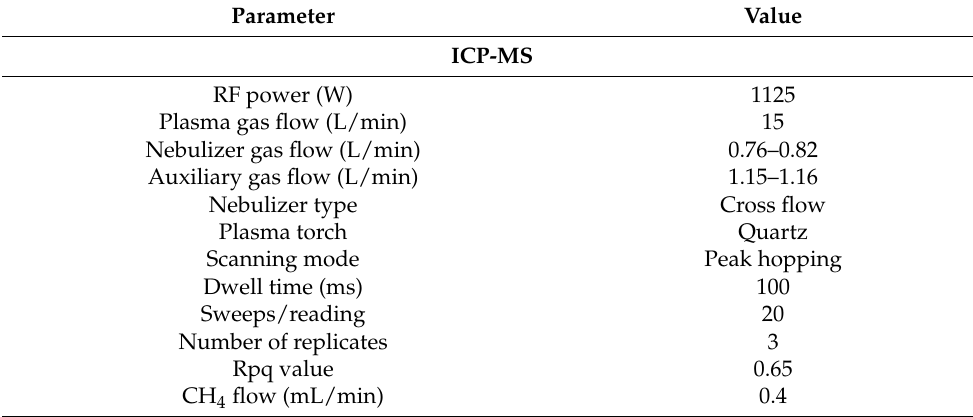
Table 5. Operating parameters of the